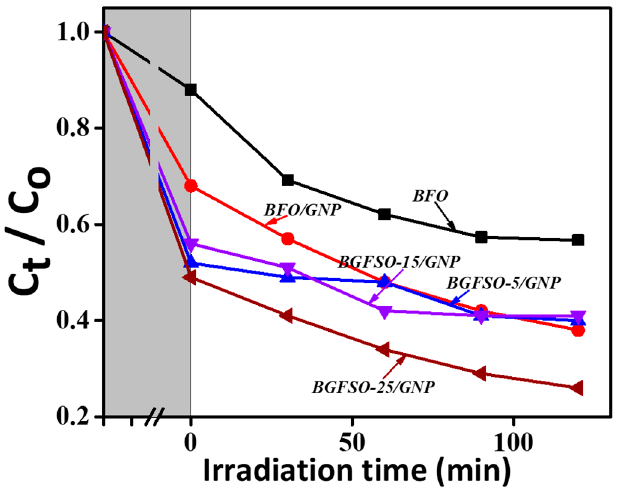
Figure 7. Photocatalytic activities of BFO particles, BFO/GNP and BGFSO/GNP nanohybrids.